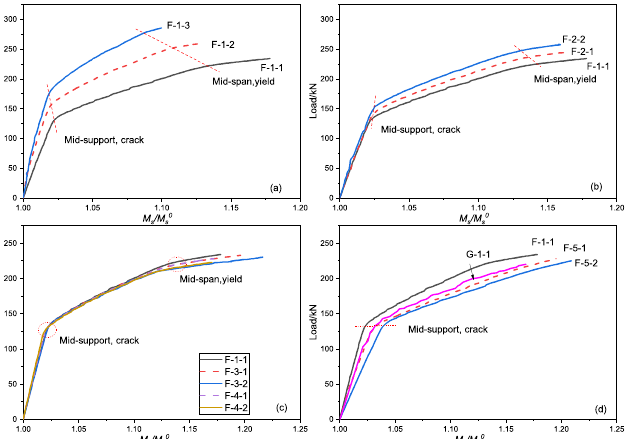
Figure 10. Variation of the secondary bending moment in the mid-support: ( a ) the initial prestress of the tendons, ( b ) the cross-sectional area of the tendons, ( c ) the cross-sectional area of the rein- forcements and the eccentricity of the tendons, and ( d ) the elastic module of the steel strand and the